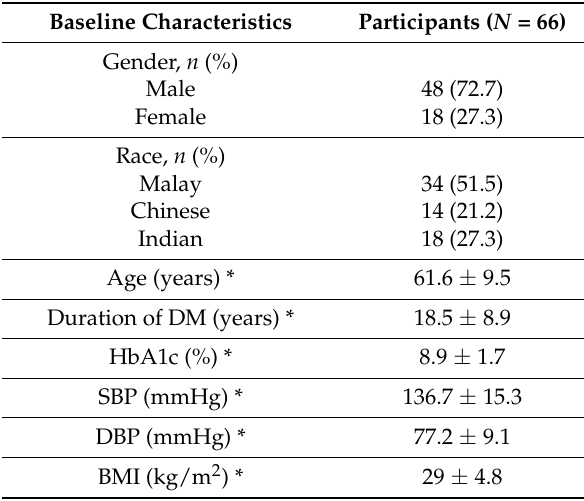
Table 1. Baseline characteristics of 66 patients with type 2 diabetes.